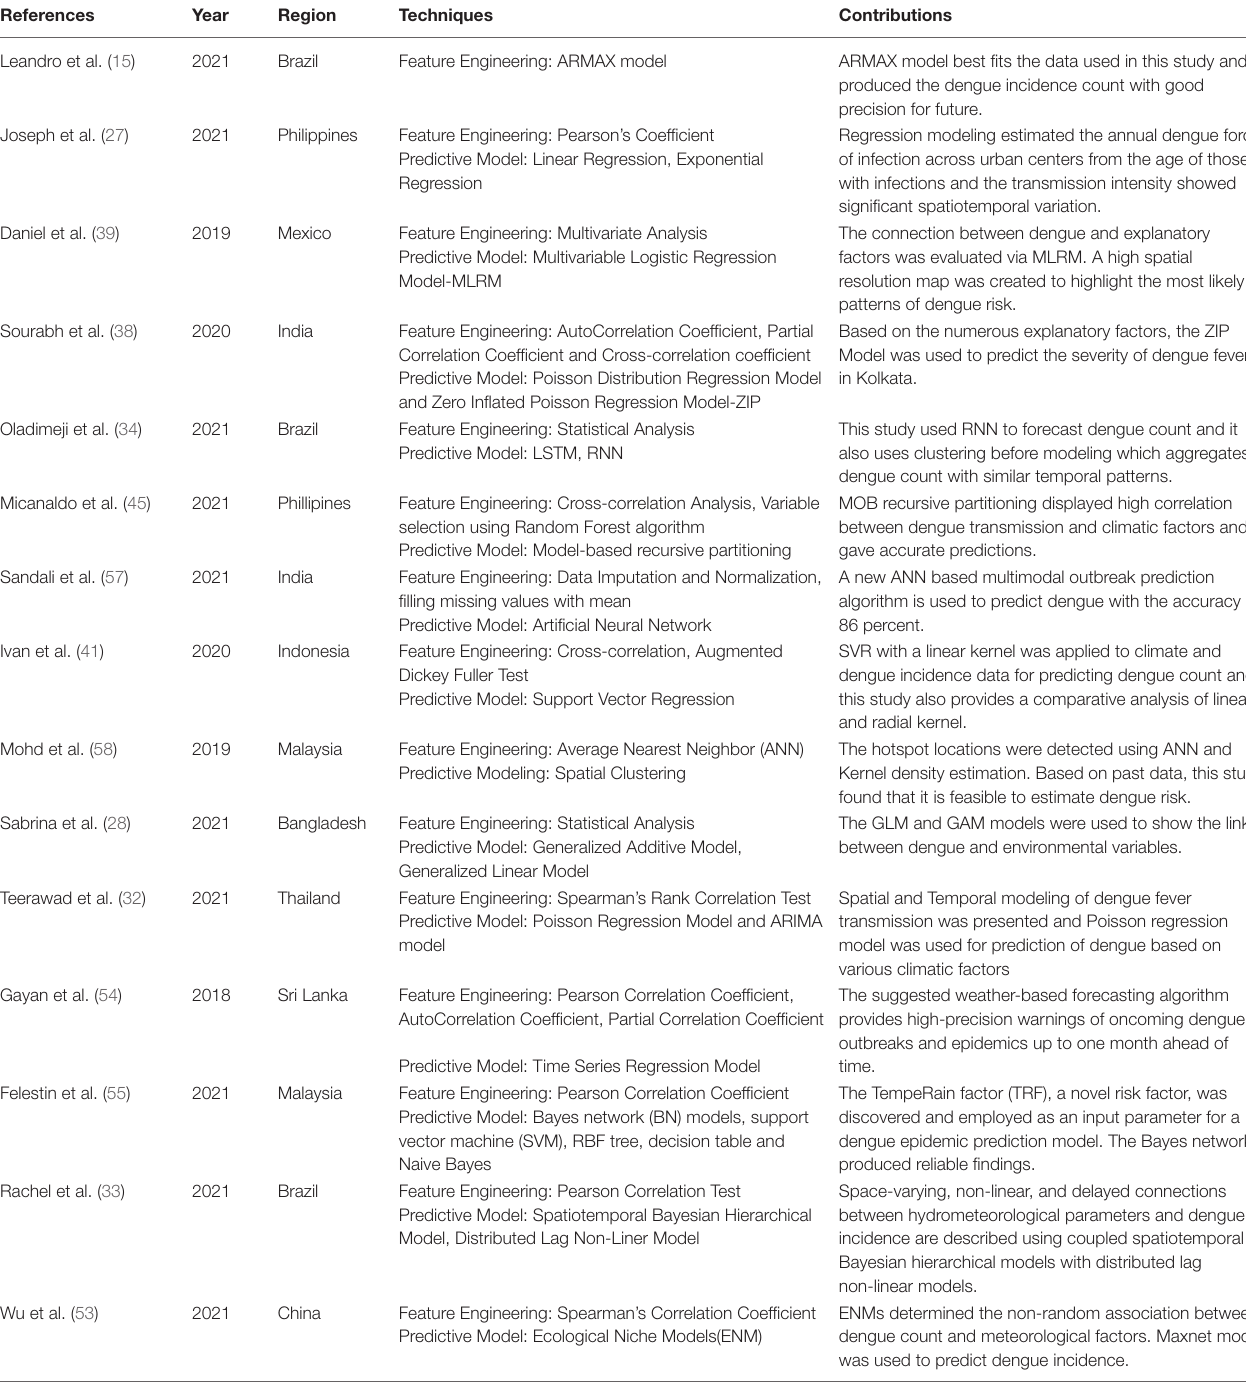
TABLE 2 | Detailed representations of different models and feature engineering techniques used in different